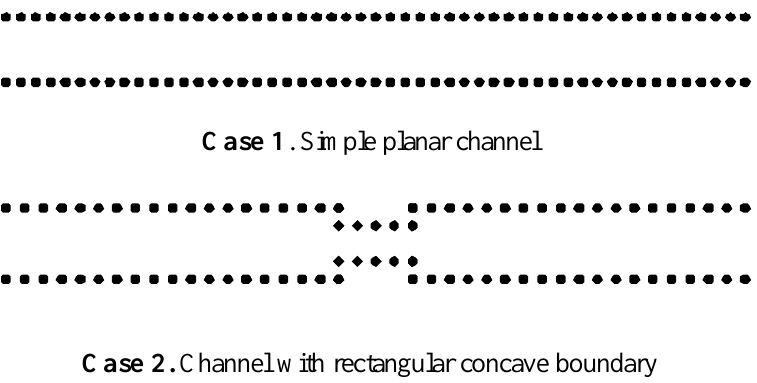
Figure 1. Schematic diagrams of nanochannels with different